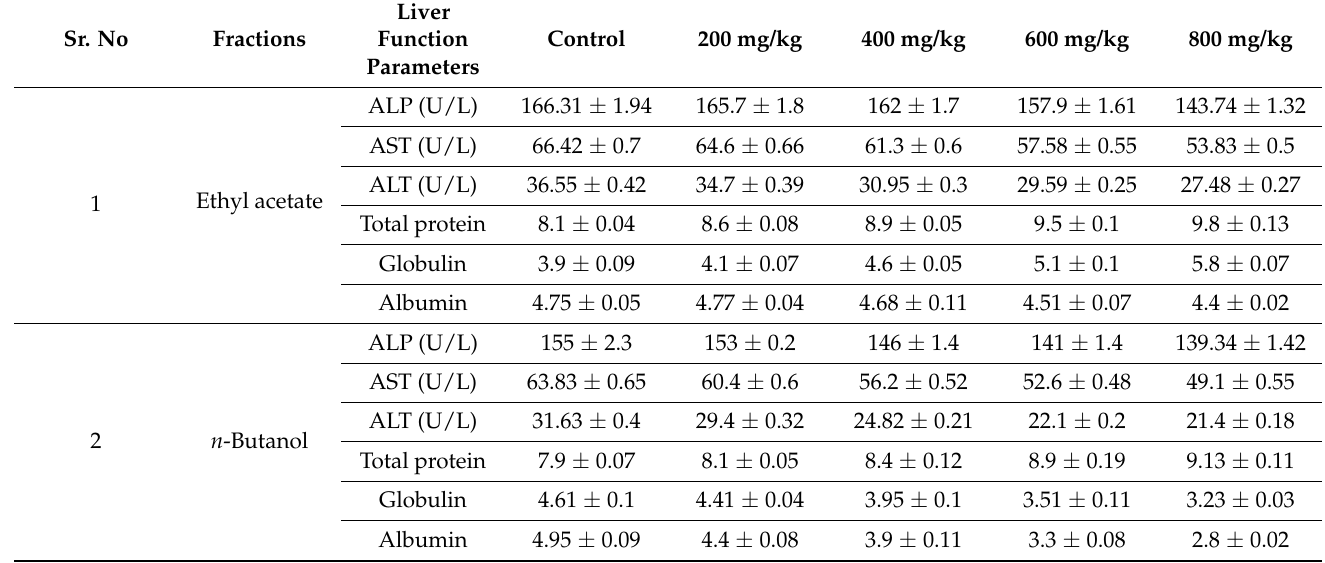
Table 4. Effects of treatment with chloroform and ethyl acetate fractions of T. vulgaris on the liver function test